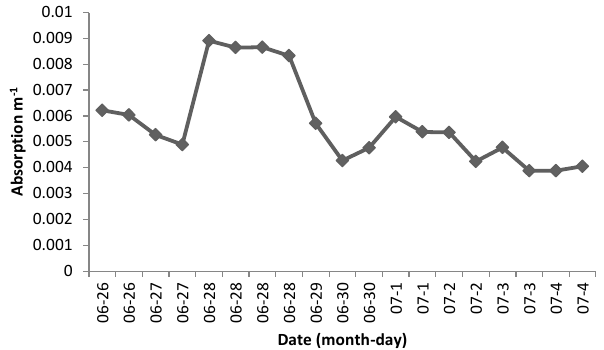
Fig. 5. Detritus semi-logarithmic slopes calculated between 400 and 500nm with 442nm as reference wavelength using a nonlinear fit.